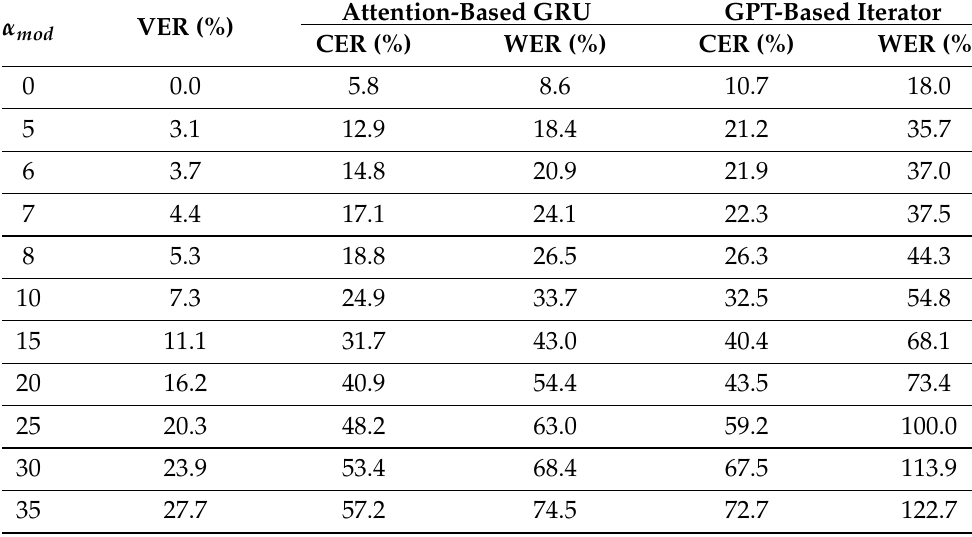
Table 7. Performance of viseme-to-word converters under varying noise levels on the LRS2 dataset.